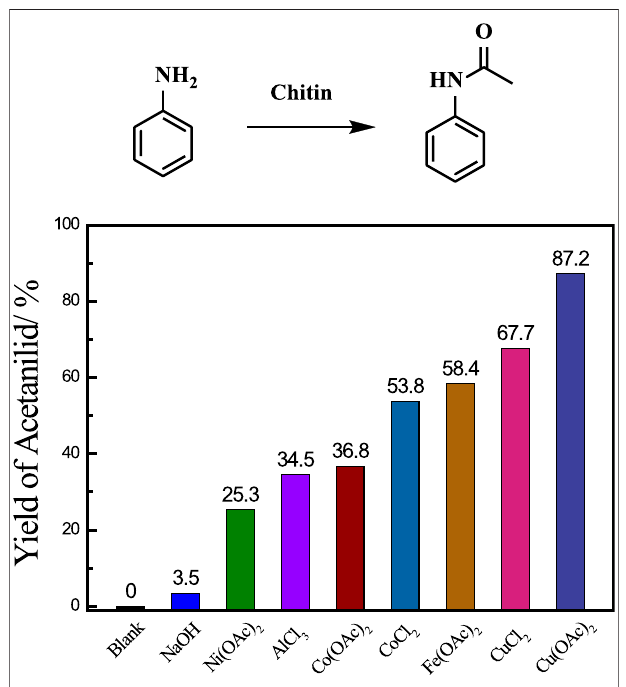
FiGURE 1 | Catalysts screening for transamidation reaction. Reaction conditions: chitin 0.1 g, aniline 0.1 ml, DMF 2.9 ml, catalyst 30 mg, 140 C, 12